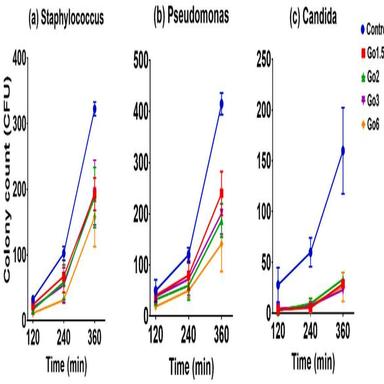
Time-Kill test: Growth chart of a) StaA, b) PseA, c) CanA treated with nanomaterials at different times. Control samples are untreated. It is based on the Colony Forming Unit in time.